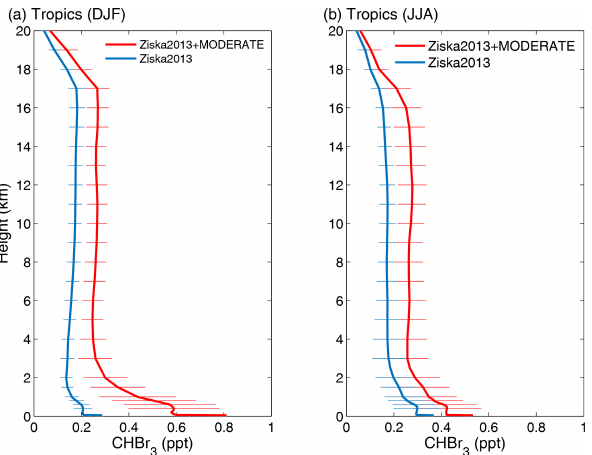
Figure 9. Height profile of seasonal mean bromoform mix- ing ratio [ppt] in the tropics (10 ◦ S–20 ◦ N, 90–120 ◦ E) for the Ziska2013 + MODERATE run (red) and Ziska2013 run (blue) for both (a) DJF and (b) JJA. Horizontal lines show the standard devi- ation for specific